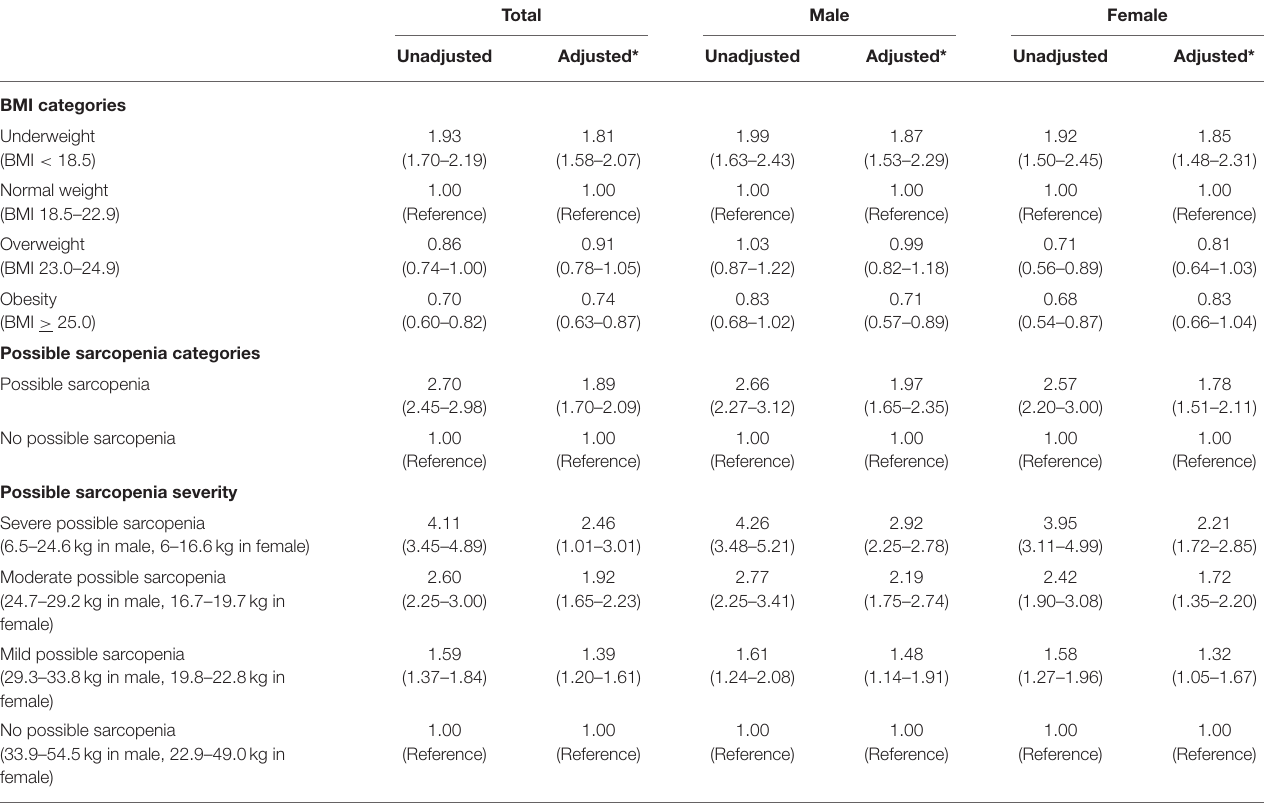
TABLE 2 | Association between 10-year all-cause mortality and body mass index (BMI), possible sarcopenia status according to AWGS 2019, and possible sarcopenia severity according to quartile of handgrip among Thai older adults who participated in the 4th Thai National Health Examination Survey (NHES-IV) ( N = 8,195). Total